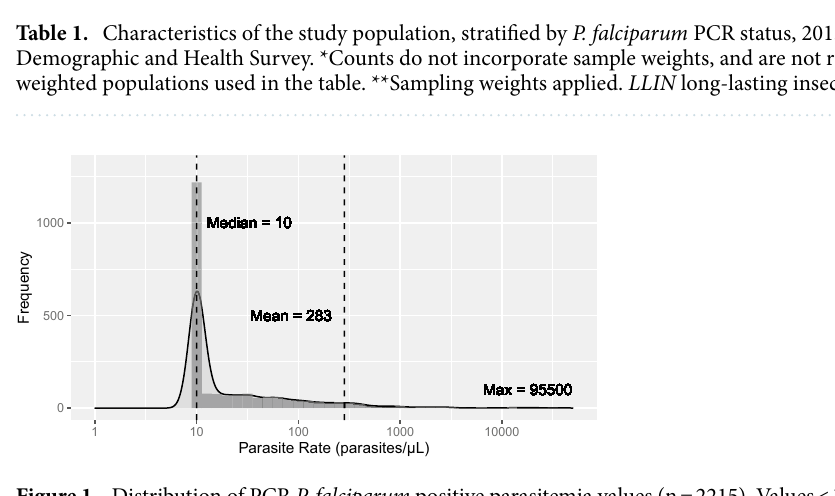
Figure 1. Distribution of PCR P. falciparum positive parasitemia values (n = 2215). Values < 10 parasites/µL are rounded up to 10 parasites/µL. The density plot’s solid line represents a normal distribution using the observed counts.